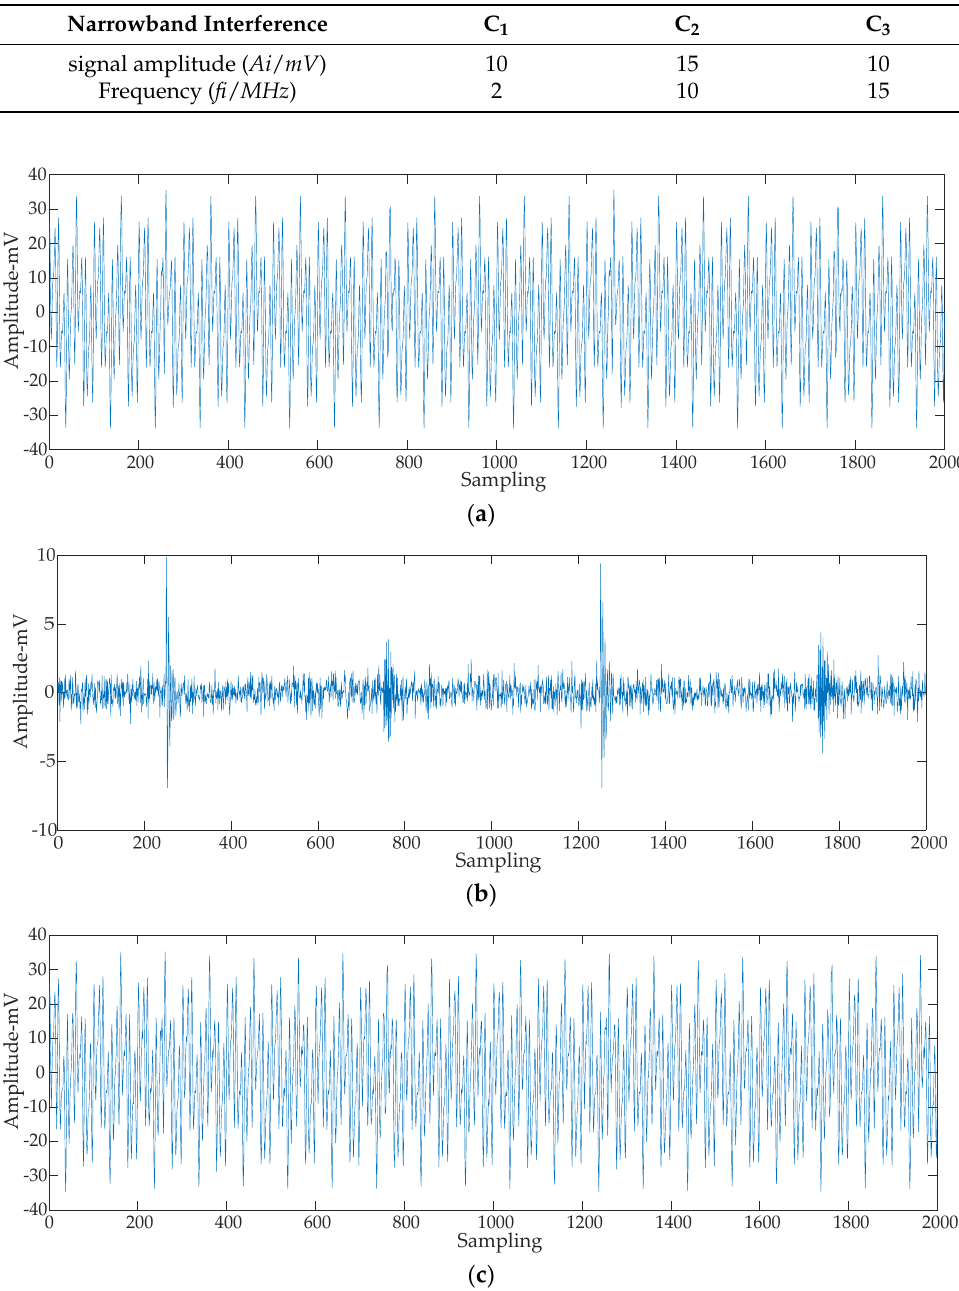
Table 2. Parameters of narrowband Interference simulation signals.